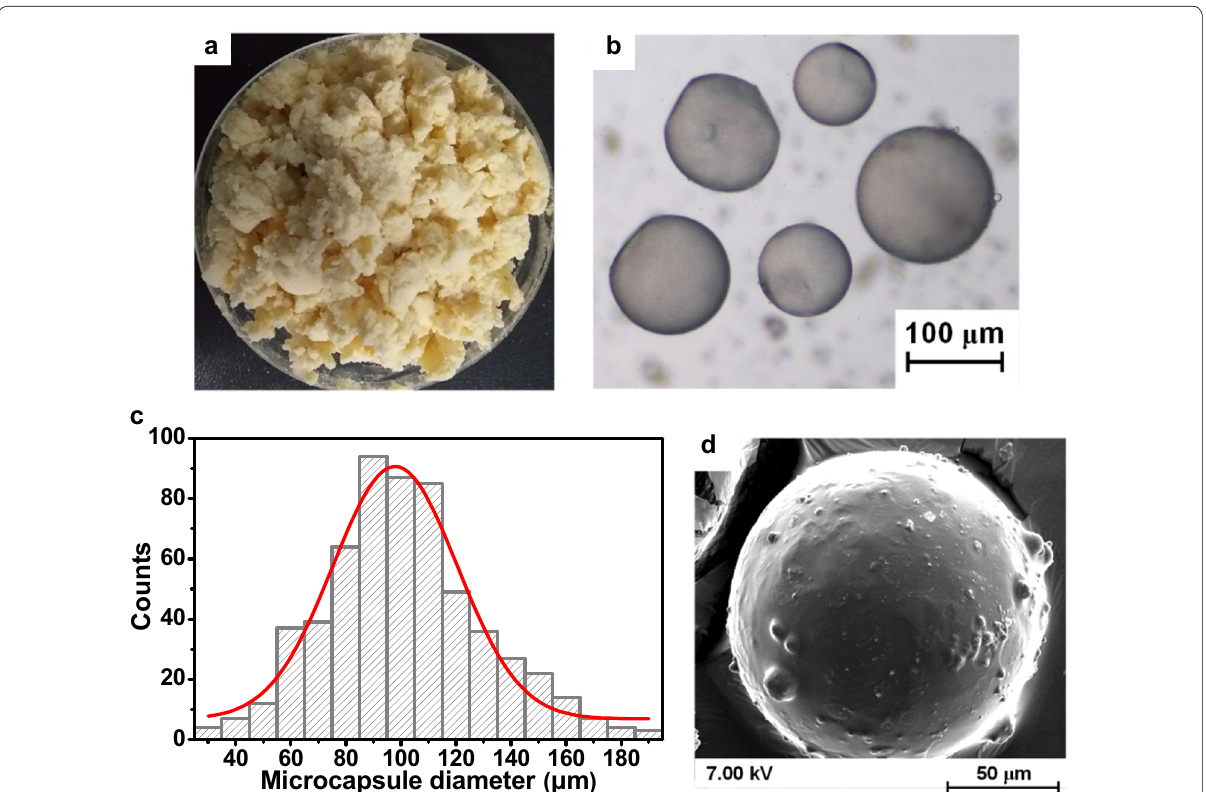
Fig. 2 a Microcapsules recovered from the suspension; b optical micrographs of microcapsules; c diameter distribution of microcapsules; d SEM micrographs of microcapsules